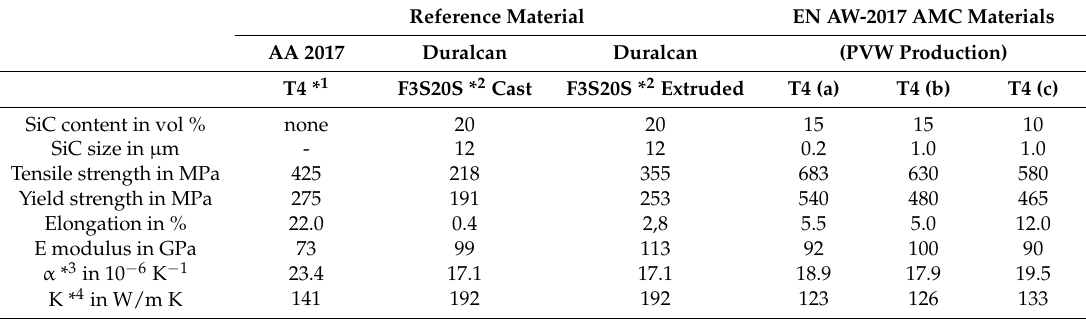
Yield strength in